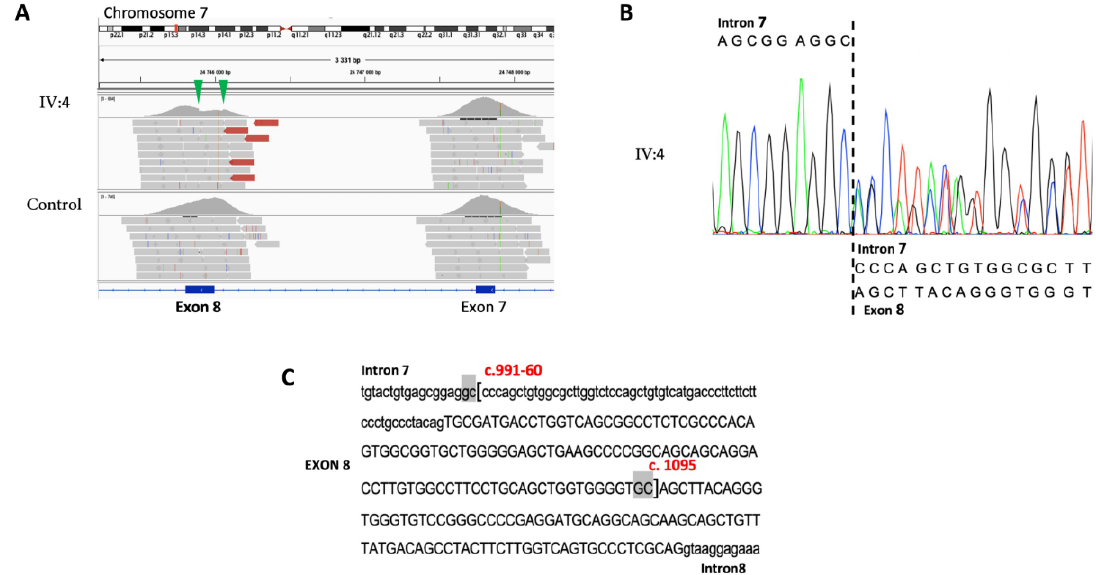
Figure 3. Identification and validation of the GSDME deletion in the proband IV:4. ( A ) Integrative genomics viewer screenshot focused on the GSDME exons 8 and 9. The sequence reads from the proband and a control are shown. Green arrowheads indicate the position of the deletion. ( B ) Sequence chromatogram of the c.991-60_1095del variant. ( C ) Sequence context of the deletion. The brackets indicate the 5′ and 3′ breakpoints of the deletion. The 2 bp flanking microhomologies are highlighted in gray.